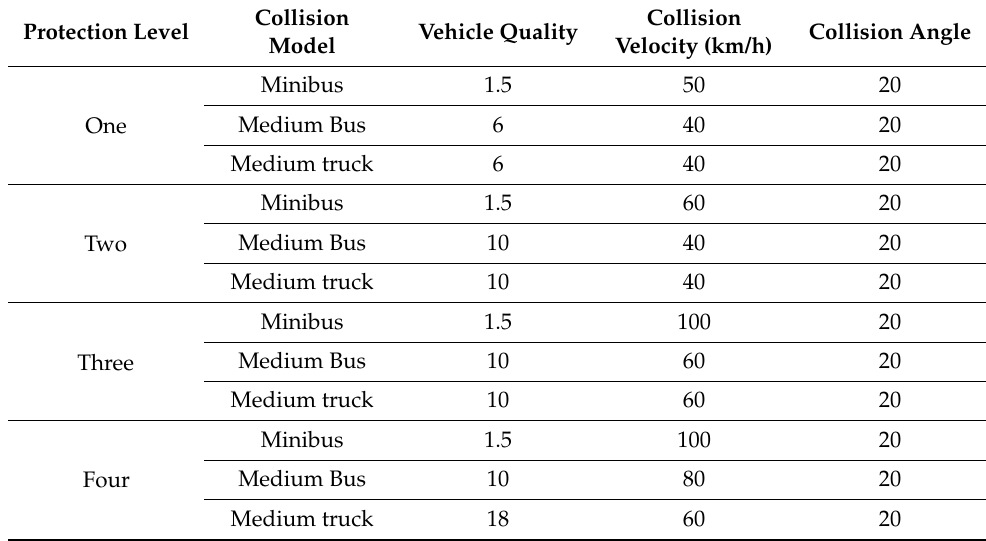
Table A3. Test collision conditions of a standard guardrail section, a transitional guardrail section, and central partition with an opening guardrail.